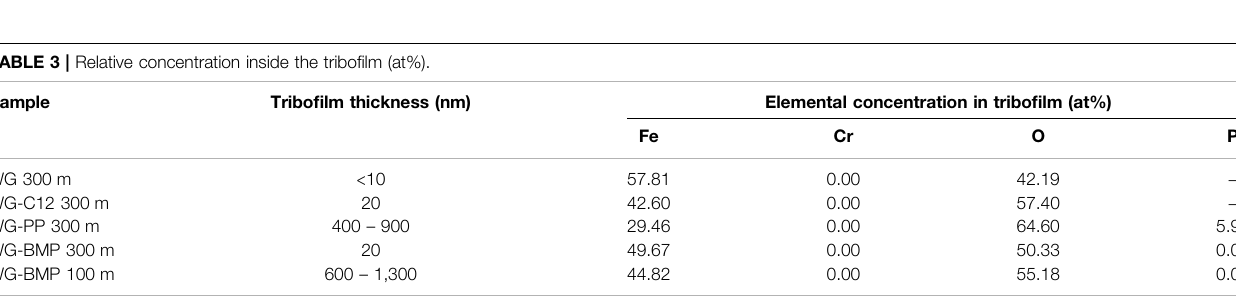
TABLE 3 | Relative concentration inside the tribo fi lm